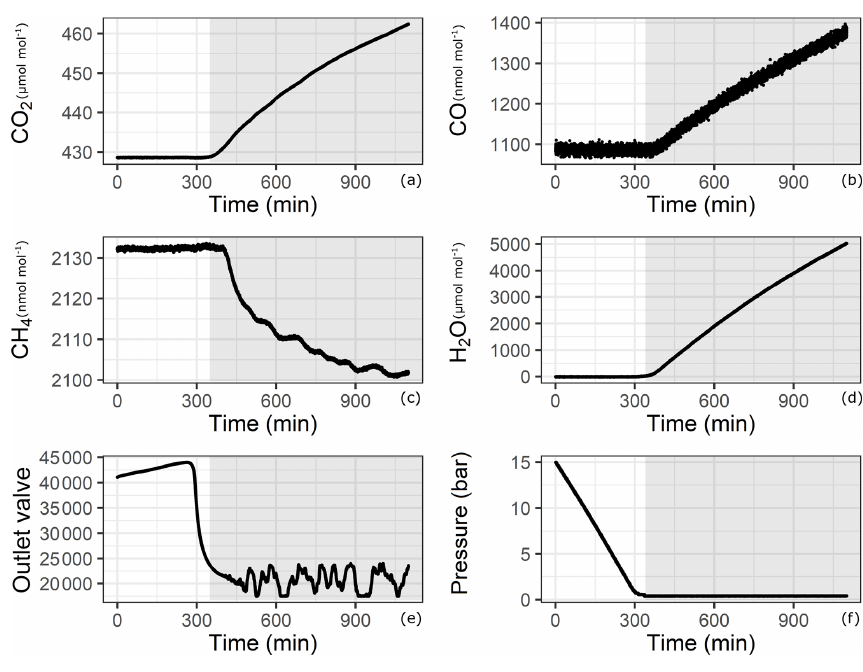
Figure 3. Analyzer response with respect to time for (a) CO 2 , (b) CO, (c) CH 4 , (d) H 2 O, (e) outlet valve and (f) pressure in the cylinder. Shaded areas correspond to the depletion of sample flow.